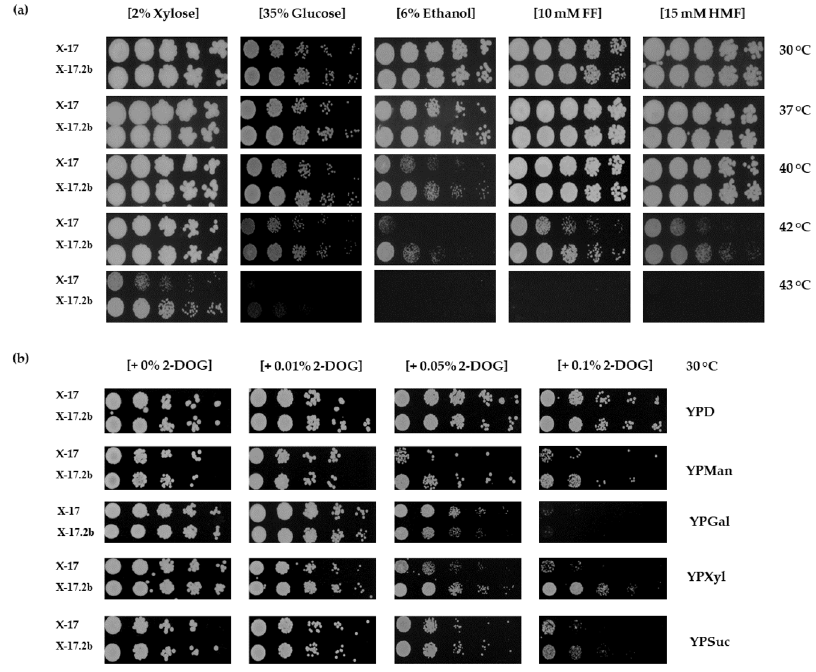
Figure 1. Stress resistance and effects of 2-DOG on sugar utilization of C. tropiclis X-17 and adapted strain C. tropiclis X-17.2b. Serially diluted cells were spotted onto ( a ) YP2X, YP35D and YP2X agar plates supplemented with 6% ethanol, 10 mM furfural or 15 mM HMF and ( b ) YPD, YPMan, YPGal, YPXyl and YPSuc agar plates supplemented with or without 0.01%, 0.05% or 0.1% 2-DOG. The plates were incubated (a) at 30 °C, 37 °C, 40 °C, 42 °C and 43 °C and (b) at 30 °C for 48 h.